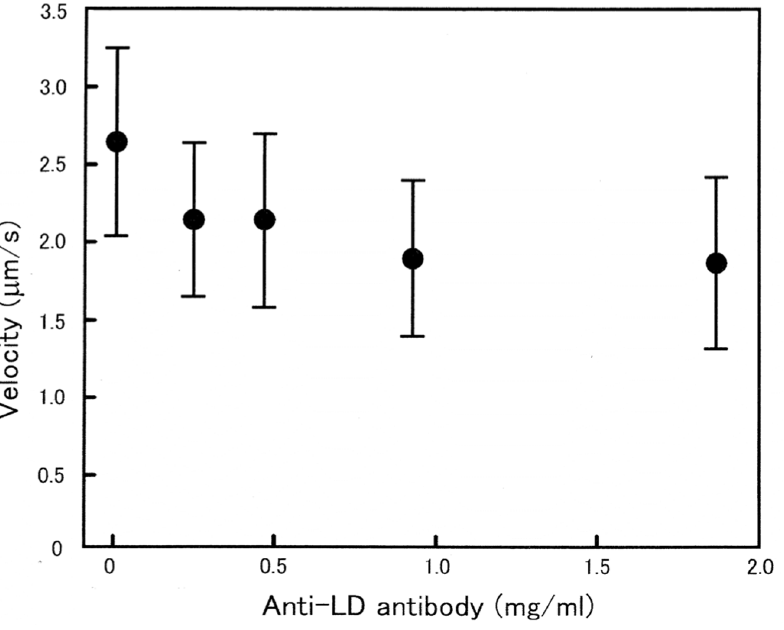
Figure 6. No appreciable effect of anti-LD antibody on invitro actin filament sliding on myosin heads.